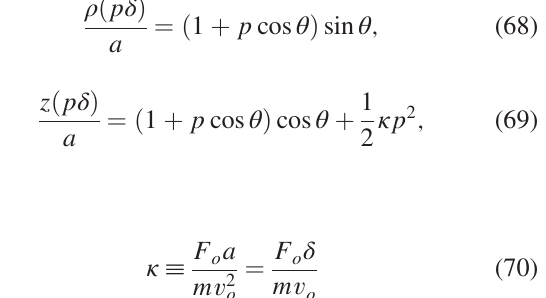
for a boss normalized with z . On the surface of the boss, o